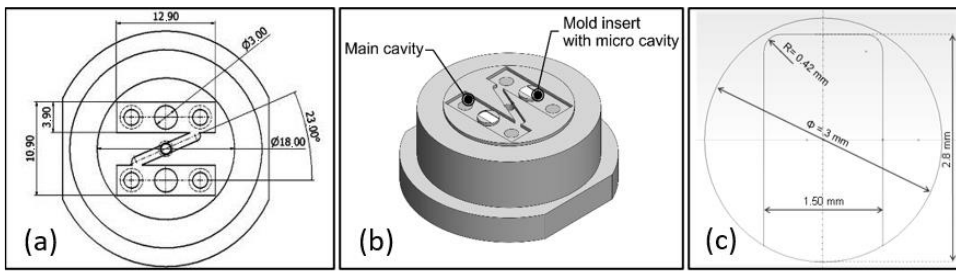
Figure 1. ( a , b ) mold and ( c ) insert designs and dimensions; sizes in ( a , c ) are reported in mm.